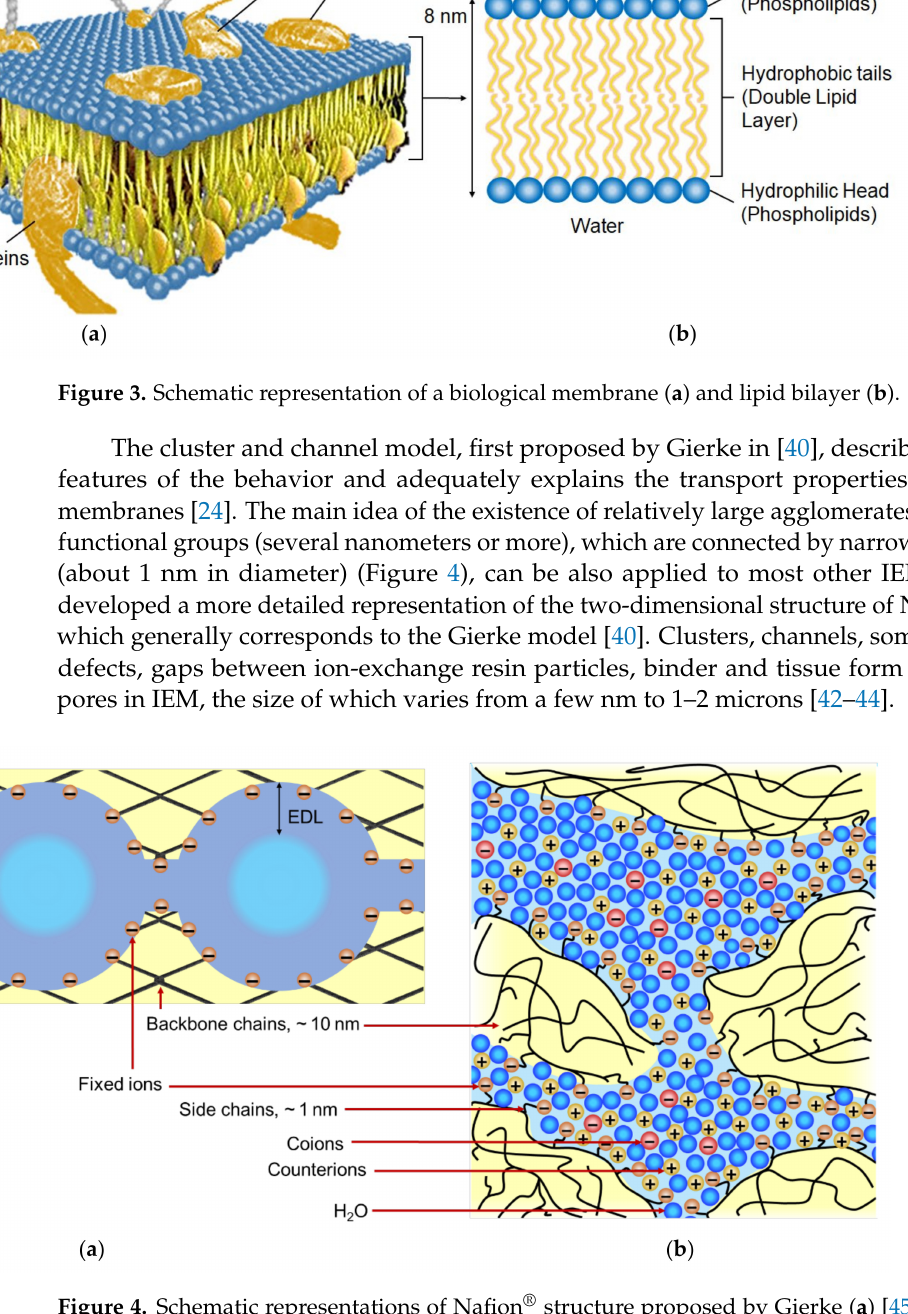
Figure 4. Schematic representations of Nafion ® structure proposed by Gierke ( a ) [45] and Kreuer ( b ) [41]. An electrical double layer (EDL) is formed at the charged pore wall, and an electrically neutral solution is present in the center of the